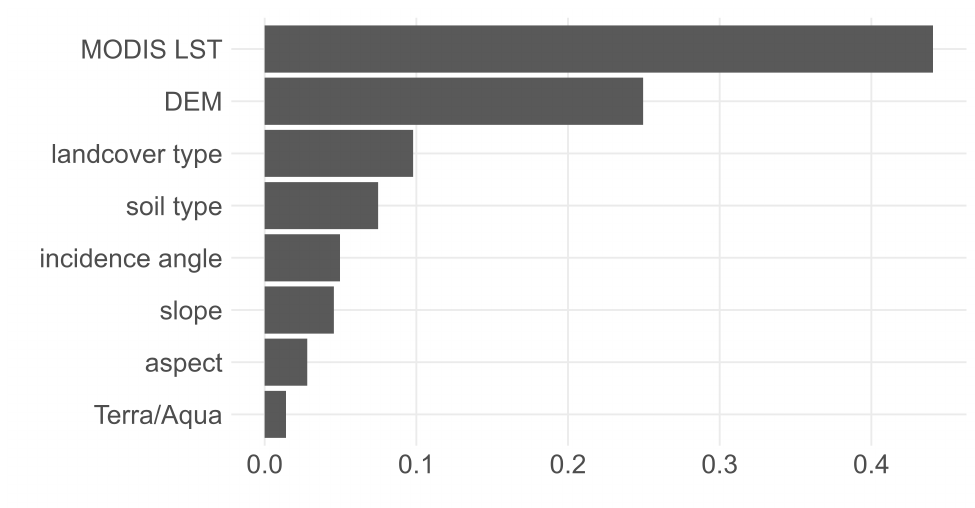
Figure 7. Variable importance of the downscaling model, in percent.